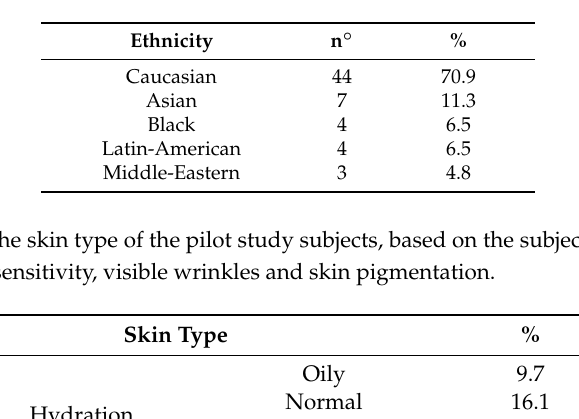
Table 2. Analysis of the ethnicity of the pilot study subjects.